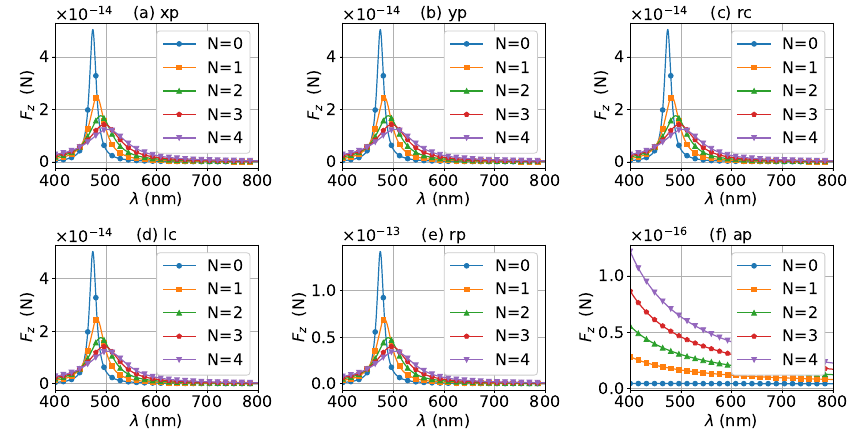
Figure 14. The same as in Figure 12, but with α 0 = 80 ◦ .